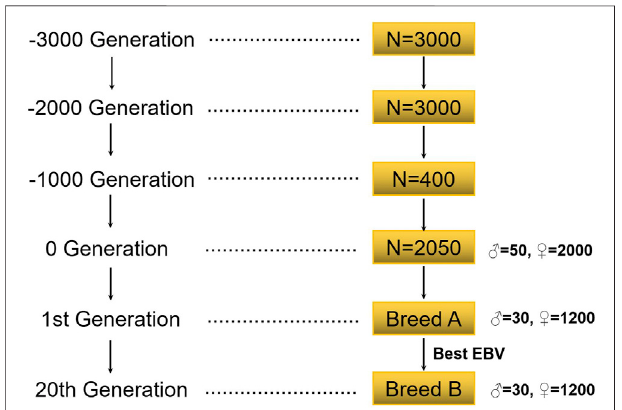
FIGURE 1 | The fl ow of population